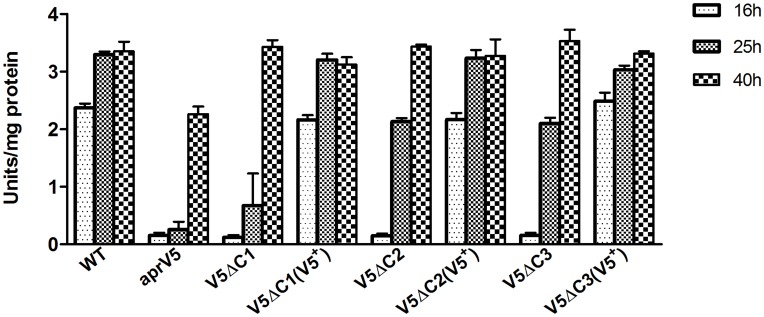
Quantitative analysis of protease activity of deletion mutants.Total protease activity in culture supernatants was determined with azocasein as the substrate. The culture supernatants from 16 h, 25 h and 40 h TAS broth cultures of the wild type strain VCS1703A (WT), the aprV5 mutant JIR3756 (aprV5), the aprV5Δ478–595 strain JIR3947 (V5ΔC1), the aprV5Δ503–595 strain JIR3956 (V5ΔC2), the aprV5Δ560–595 strain JIR3969 (V5ΔC3) were analysed as well as their complemented derivatives: JIR3968 (V5ΔC1(V5+)), JIR3965 (V5ΔC2(V5+)) and JIR3978 (V5ΔC3(V5+)). All values were obtained from three independent biological samples. Error bars represent SEM.